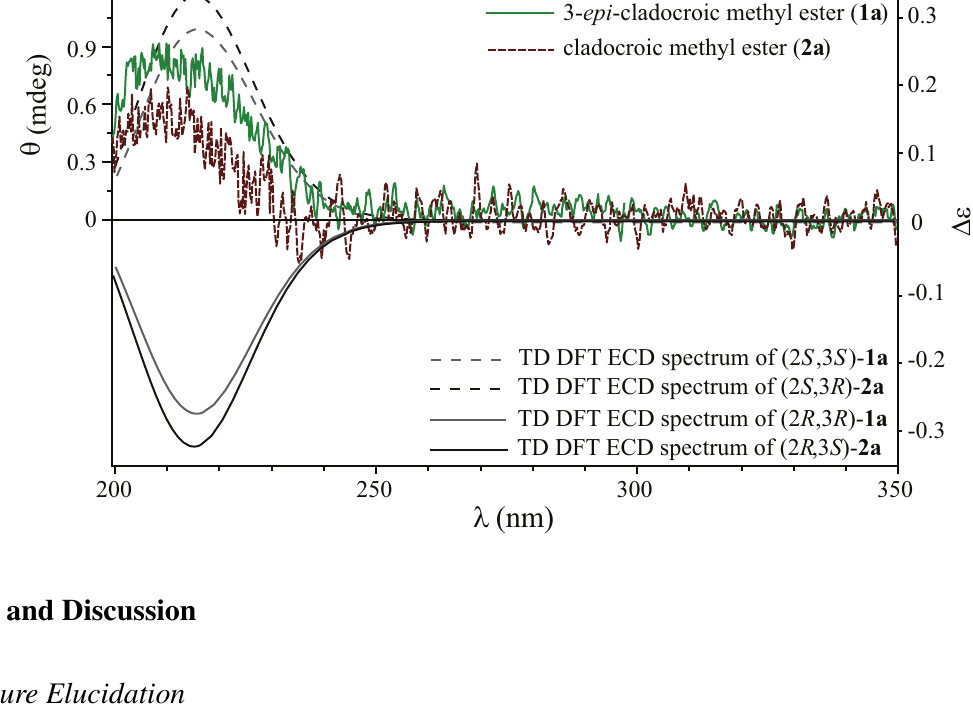
Figure 2. Experimental ECD spectra of compounds 1a and 2a with the theoretical TD-DFT calculated spectra of both enantiomers of compounds 1a and 2a without the alkyl enyne terminus